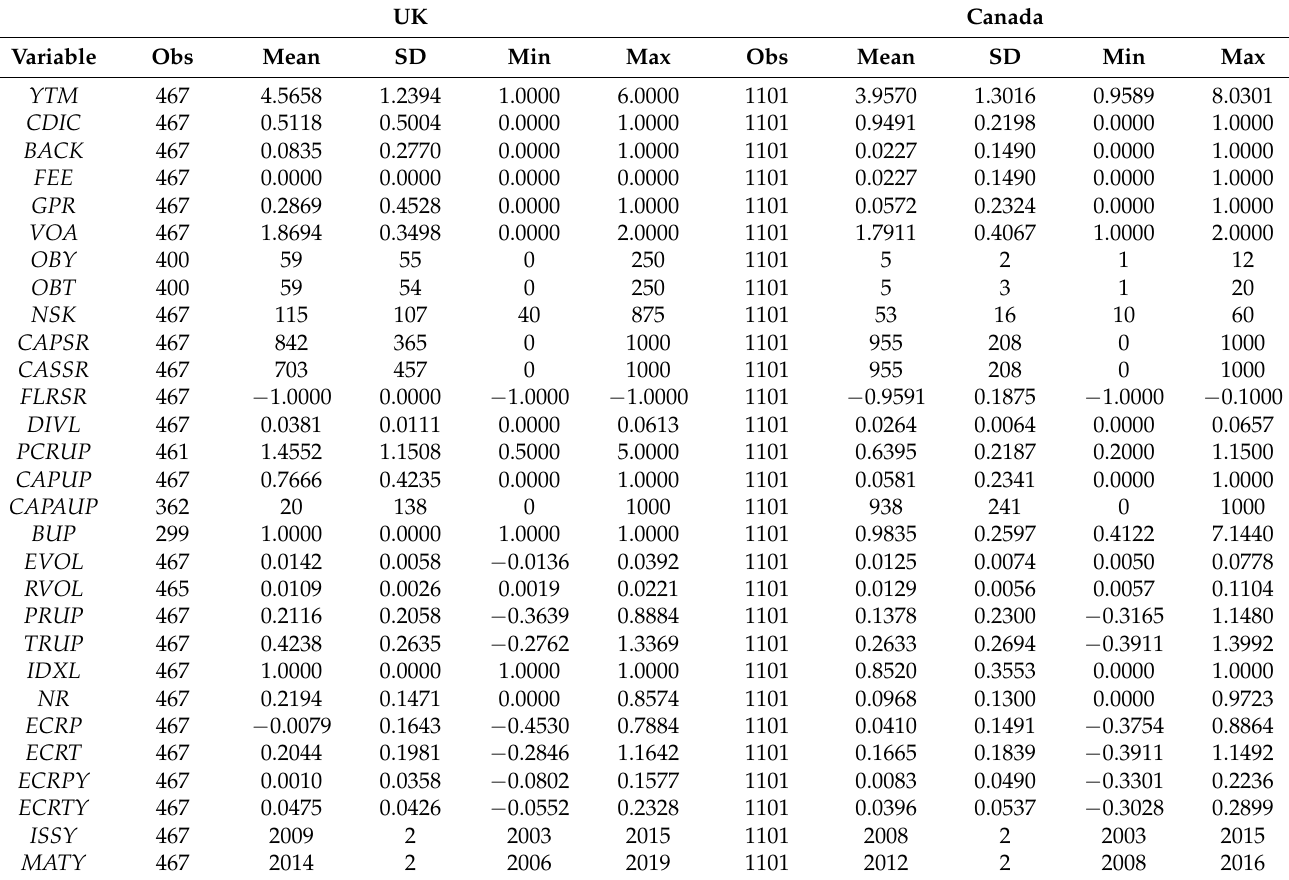
Table 7. The summary statistics for the return adjustment